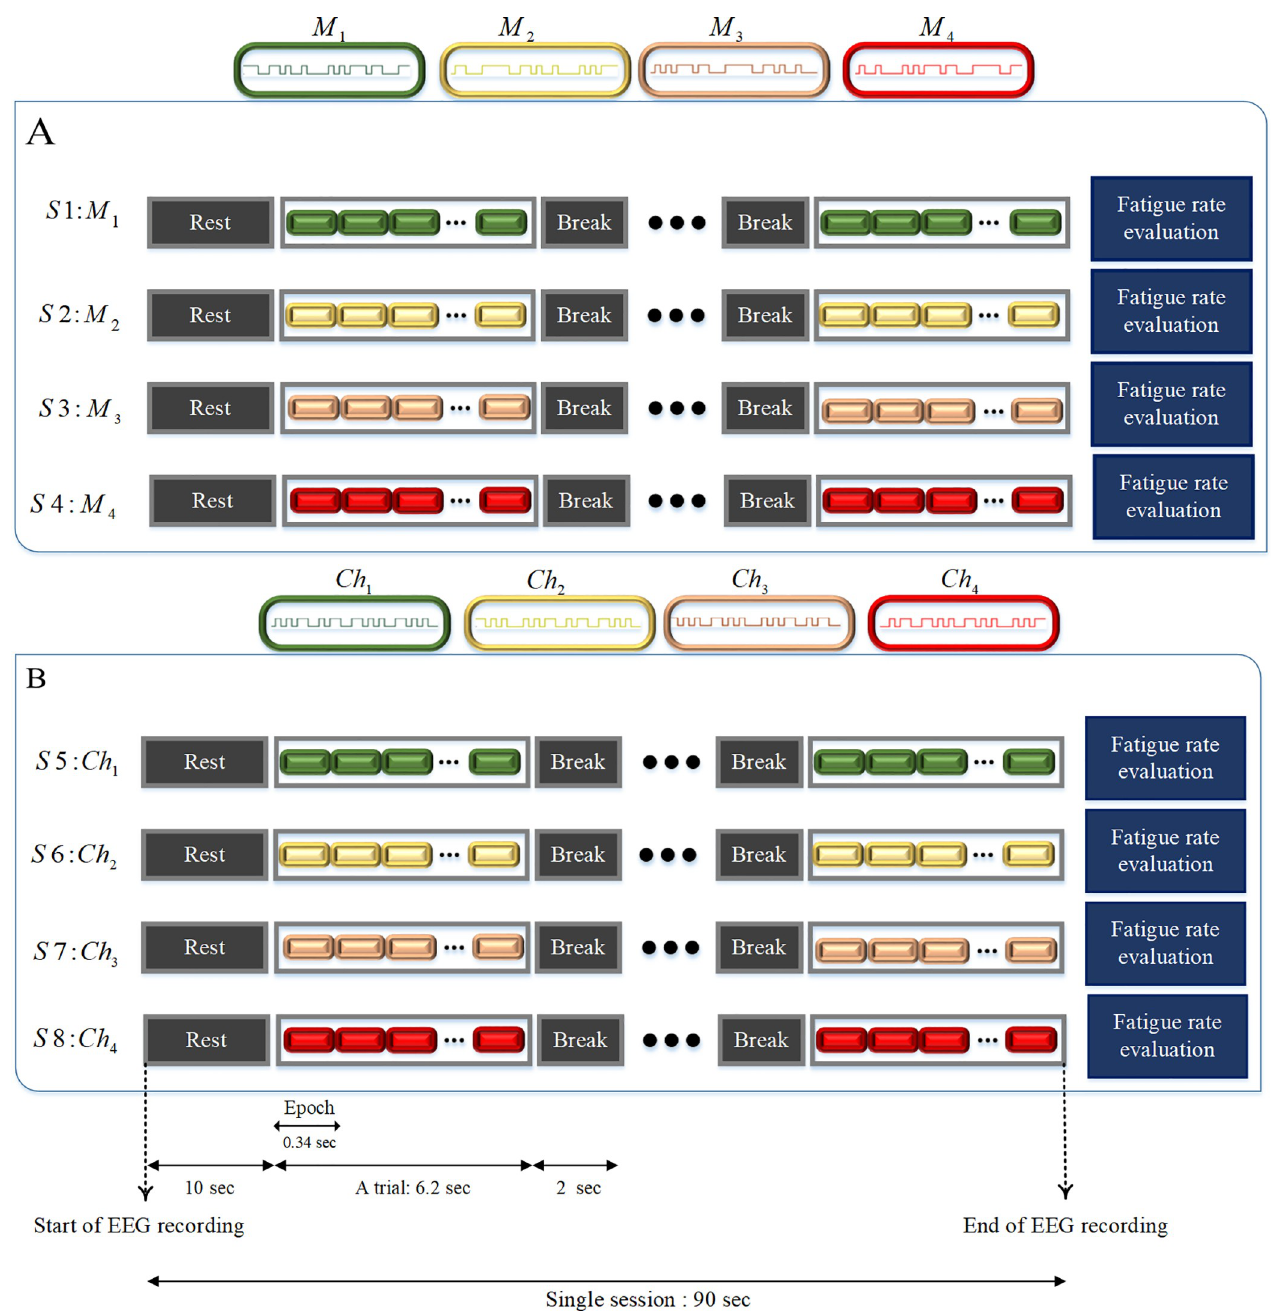
Fig 7. Time sequences of activities of m-sequence (A) and chaotic code (B) presentation sessions. Each subject was presented with eight sessions. Each session started with 10 second rest and EEG recording and consisted of 10 trials. Each trial consisted of 18 epoch of consecutive m-sequence or chaotic codes presented with 2 seconds break after each trial. At the end of each session subjective fatigue rate was evaluated. The order of presentation of eight sessions for each subject was